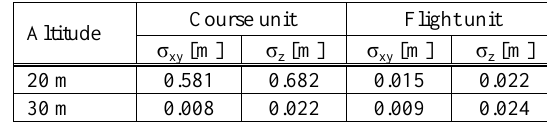
Table 6. Accuracy for a given condition of GNSS +